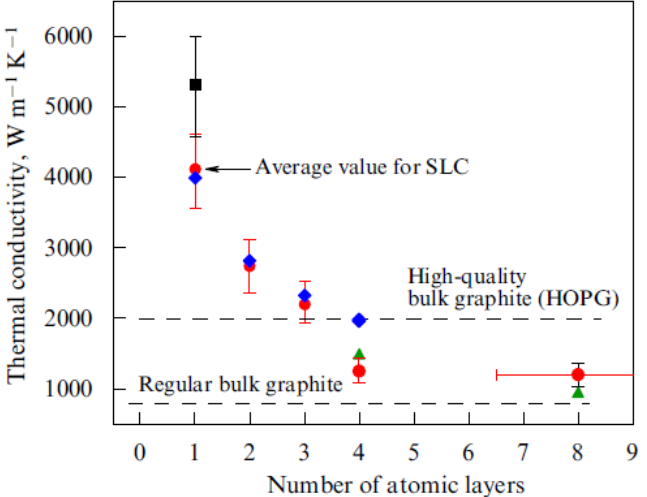
Figure 5. Dependence of the longitudinal thermal conductivity of few-layer graphene films on the number of layers [54]. The dashed lines indicate the limits of spreading the thermal conductivity of crystalline graphite; diamonds: calculated results considering all the possible phonon scattering mechanisms, excluding the scattering on defects; triangles: calculations [56–59] for multilayer graphene structures taking into account the roughness; square: maximum magnitude [53]; dots: averaged value for a suspended graphene sheet 5 mm in length. All the measurements were performed at room temperature.